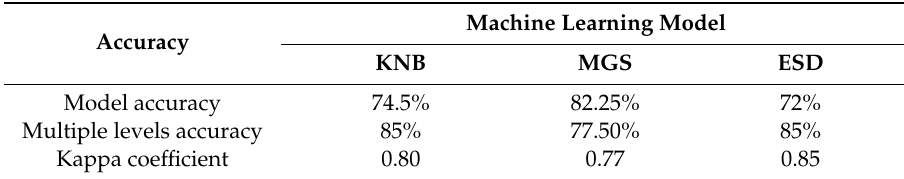
Table 7. Classification